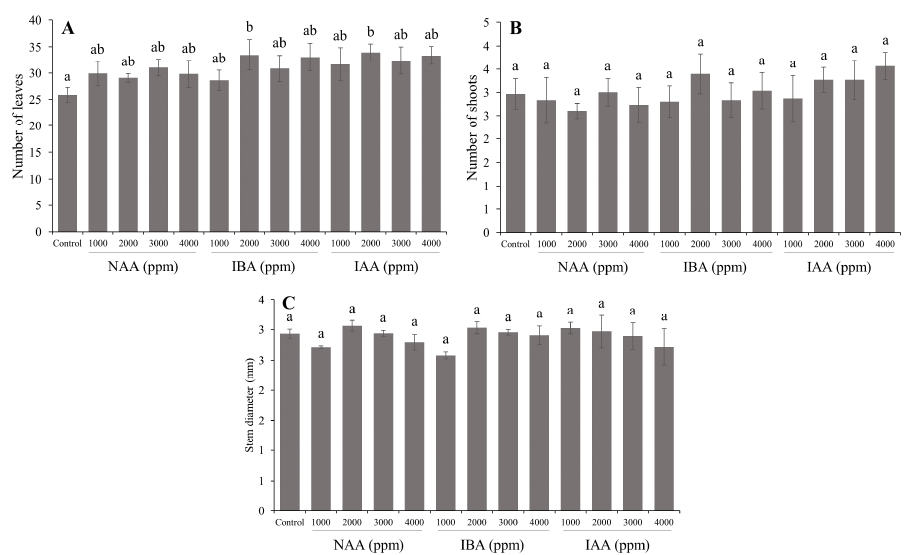
Figure 5. Effect of auxin treatment: ( A ) number of leaves; ( B ) number of shoots; ( C ) stem diameter of Jasminum parkeri stem cuttings. Different letters indicate significant mean difference among treatments (DMRT, p ≤ 0.05).